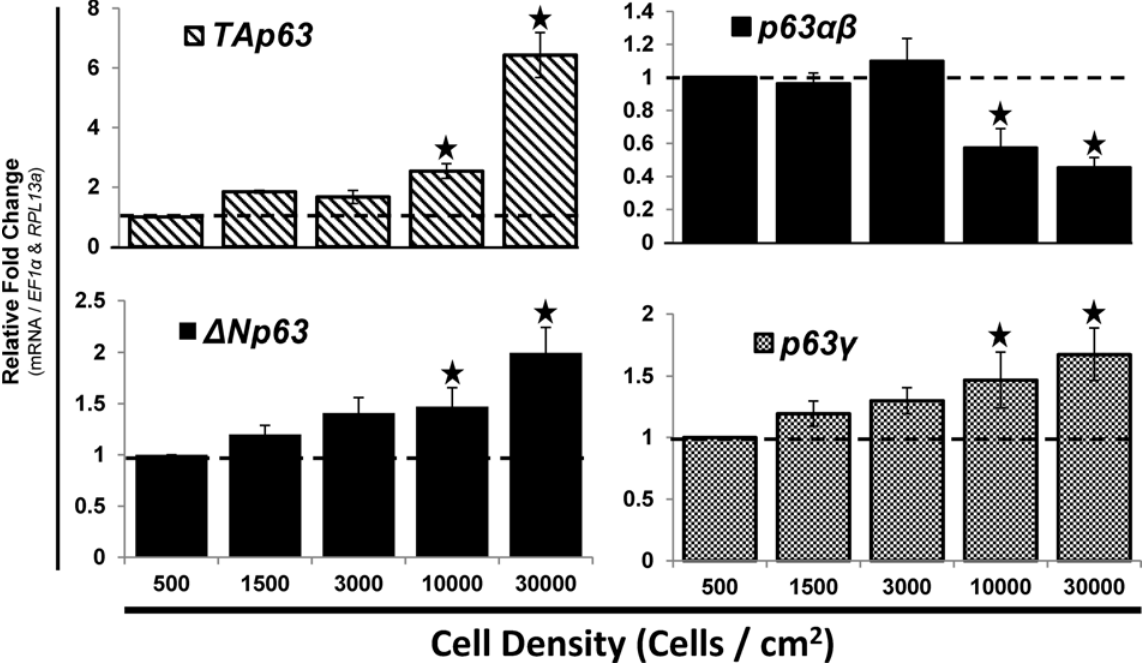
Fig 2. The mRNA expression of p63 gene variants is dependent on seeding cell density of hMSC. hMSC were seeded at various densities, ranging from 500 – 30,000 cell/cm 2 , and then grown under expansion conditions for 3-days followed by RT-qPCR analysis of p63 gene products. RT-qPCR analysis of p63 isoforms (left panel, TA- and Δ Np63 ) and splice variant mRNA (right panel, p63 α / β and p63 γ ) expression. N = 3 independent experiments in triplicate. ( * ) p (cid:1) 0.05 compared to hMSC seeded at 500 cells/cm 2 , which were set to the value of “ 1 ” . hMSC used were from a 7 and 22 year old